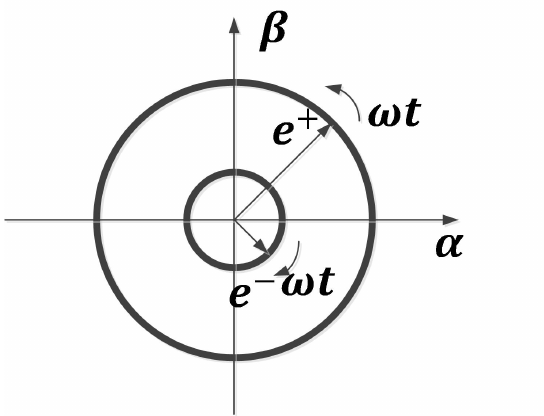
Figure 6. Schematic diagram of the positive and negative sequence αβ coordinate system of the grid